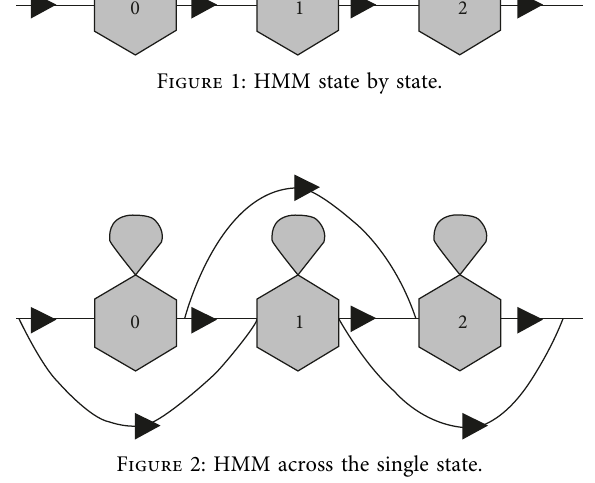
Figure 2: HMM across the single state.